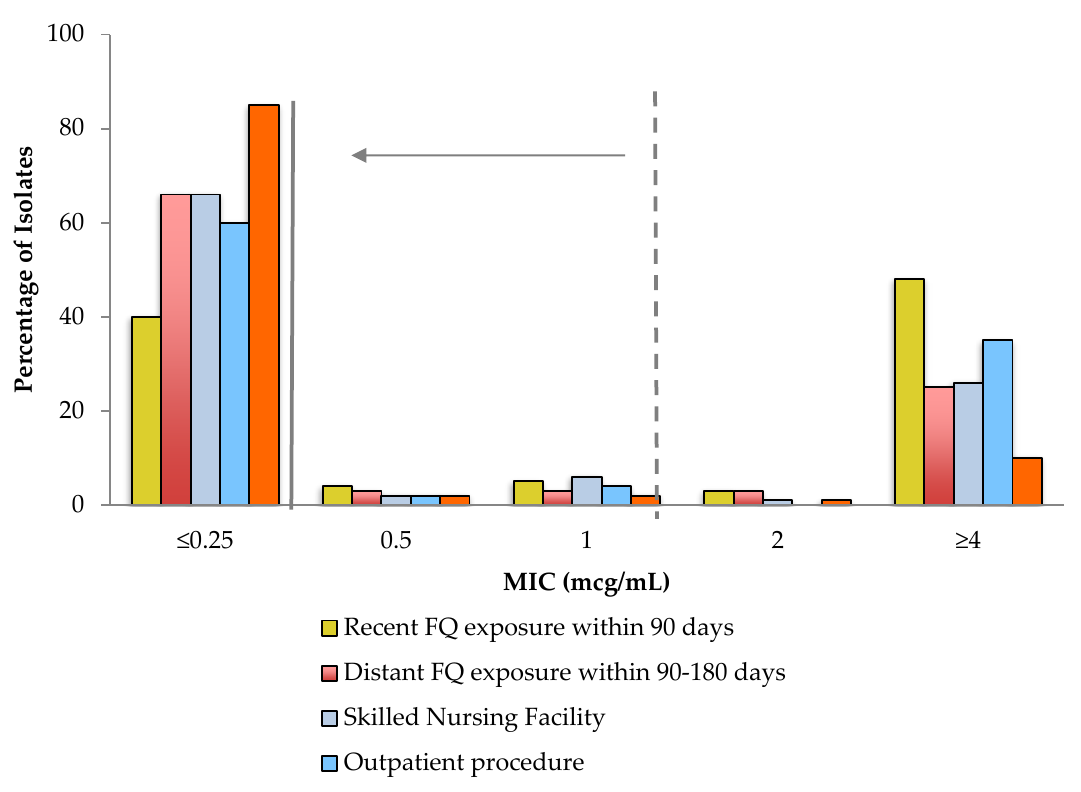
CI: confidence interval; GI: gastrointestinal; GU: genitourinary. * Patients may have multiple risk factors for fluoroquinolone resistance.